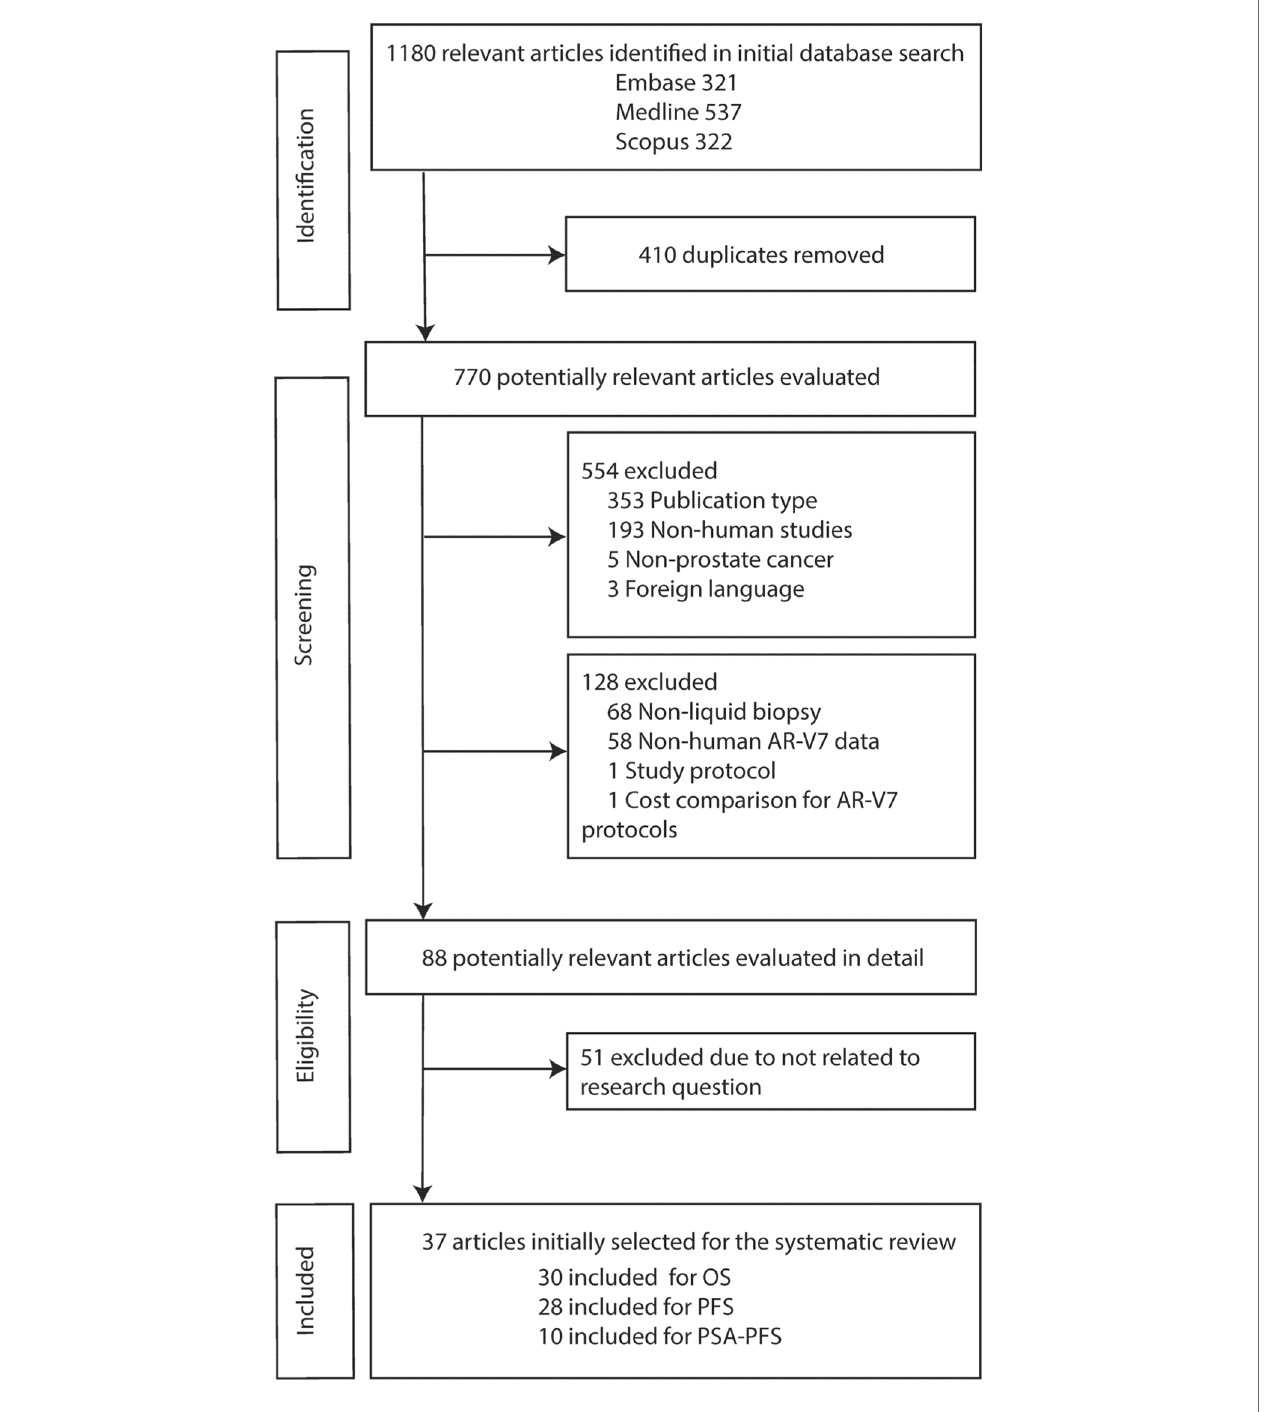
FIGURE 1 | Flow chart of literature search and study